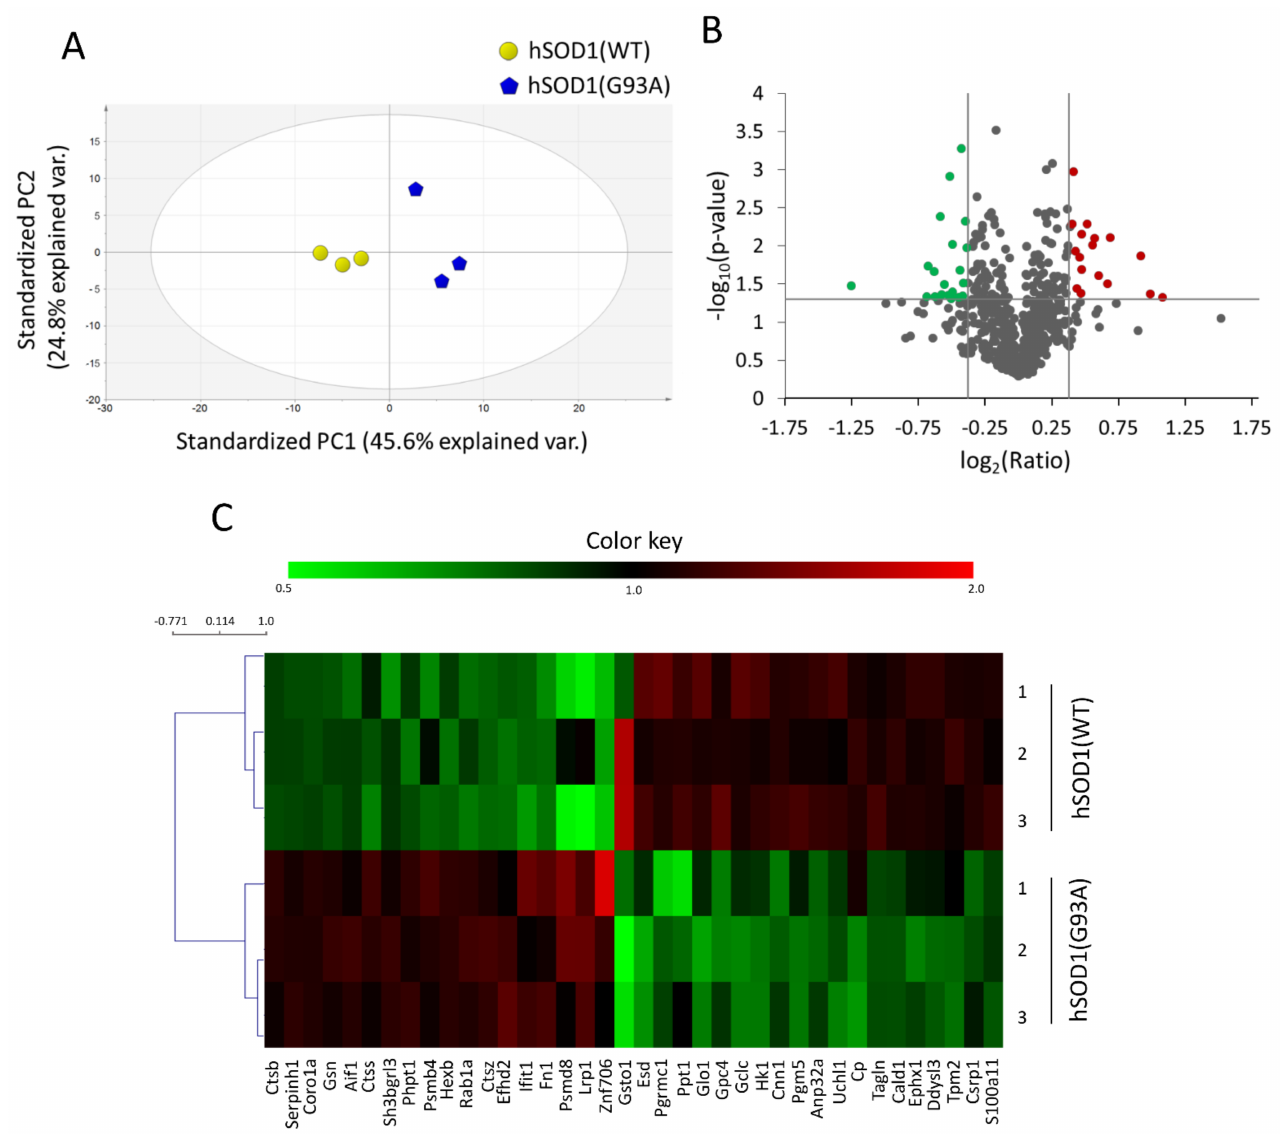
Figure 2. TMT-MS approach unveils protein abundance alterations in hSOD1(G93A) primary spinal astrocytes. ( A ) PCA score plot of the proteomic data of hSOD1(WT) (yellow circles) and hSOD1(G93A) (blue pentagons) primary astrocytes. The percentage of variance explained by the first two principal components (PC1 and PC2) is reported in each axis of the plot. Ellipse: Hotelling’s T2(95%). ( B ) Volcano plot distribution of the 640 quantified proteins, mapping the most significant 20 downregulated (green circles), and 18 upregulated (red circles) proteins in primary spinal cord astrocytes derived from hSOD1(G93A) mice compared to hSOD1(WT) matched controls, satisfying the criteria of log 2 (fold-change) value < 0.77 e > 1.3 and p -values < 0.05. ( C ) Cluster heat map diagram of the 38 proteins whose expression levels were significantly altered in primary spinal cord astrocytes from hSOD1(G93A) mice compared to hSOD1(WT) matched samples. Hierarchical clustering tree indicates primary cultures from hSOD1(G93A) spinal cord differ from hSOD1(WT). Relative protein expression levels are reported by a pseudocolor scale, with red denoting higher and green denoting lower protein expression in hSOD1(G93A) astrocytes compared to the hSOD1(WT) counterpart,